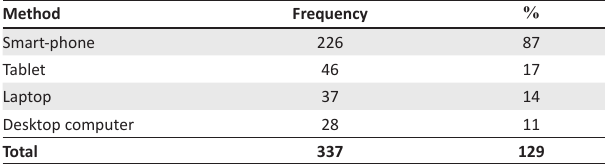
TABLE 2: Learners accessing the Internet.